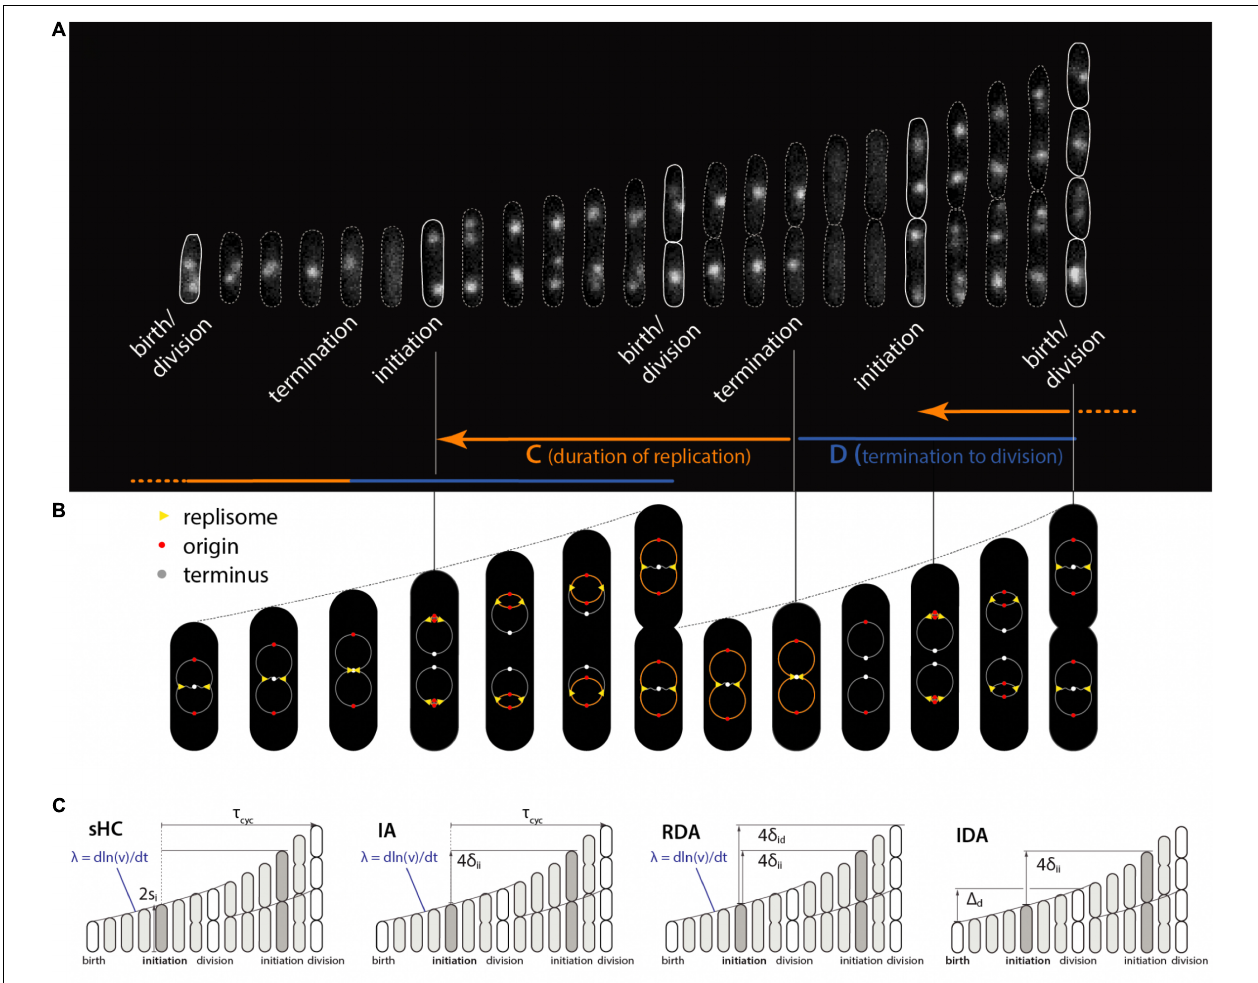
FIGURE 1 | Physiological parameters that can be measured from single-cell experiments. (A) Time-lapse images of a single Escherichia coli cell growing in a microfluidics channel. The cell boundaries are segmented from phase contrast images whereas the replication forks are visualized using a functional fluorescently labeled replisome protein (DnaN-YPet). (B) Multifork replication: in most growth conditions, several replication cycles overlap. The direction of the arrows is not the direction of time, but to illustrate that the HC model’s core idea is to trace replication initiation backward in time by C+D from division. (C) Four models of E. coli cell cycle and their control variables, which can be measured from single-cell experiments. The sHC model describes cell size and cell cycle using three parameters: elongation rate λ = dln( l )/d t , where l is the cell length (not shown), τ cyc = C + D , and the initiation size per origin of replication s i . The IA model uses λ , τ cyc and the added size per origin of replication between consecutive replication initiation events δ ii . The RDA model uses λ , δ ii and the added size per origin of replication from initiation to division δ id . The IDA model uses λ , δ ii and the added size from birth to division (cid:49) d . Note that both δ id and τ cyc can span multiple generations. The prefactor before s i , δ ii , δ id reflects multiple replication origins at initiation as depicted